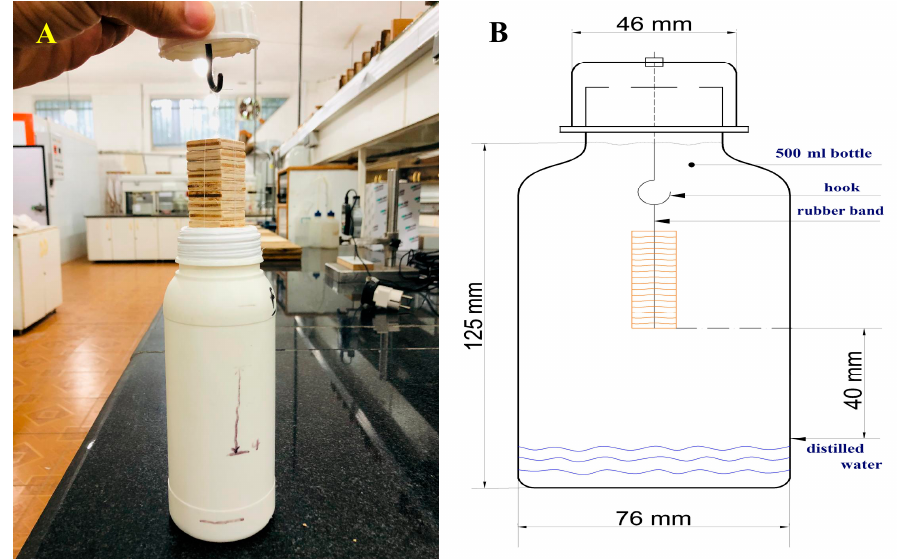
Figure 2. Test apparatus for measurement of formaldehyde gases, type 2 for the flask method (1:500 mL bottle with a top made of polyethylene plastic; 2: hook to hang specimens; 3: rubber band to suspend specimens within the flask; 4: distilled water at the bottom of the flask): ( A ) the actual flask with a set of specimens; ( B ) linear drawing of the flask.